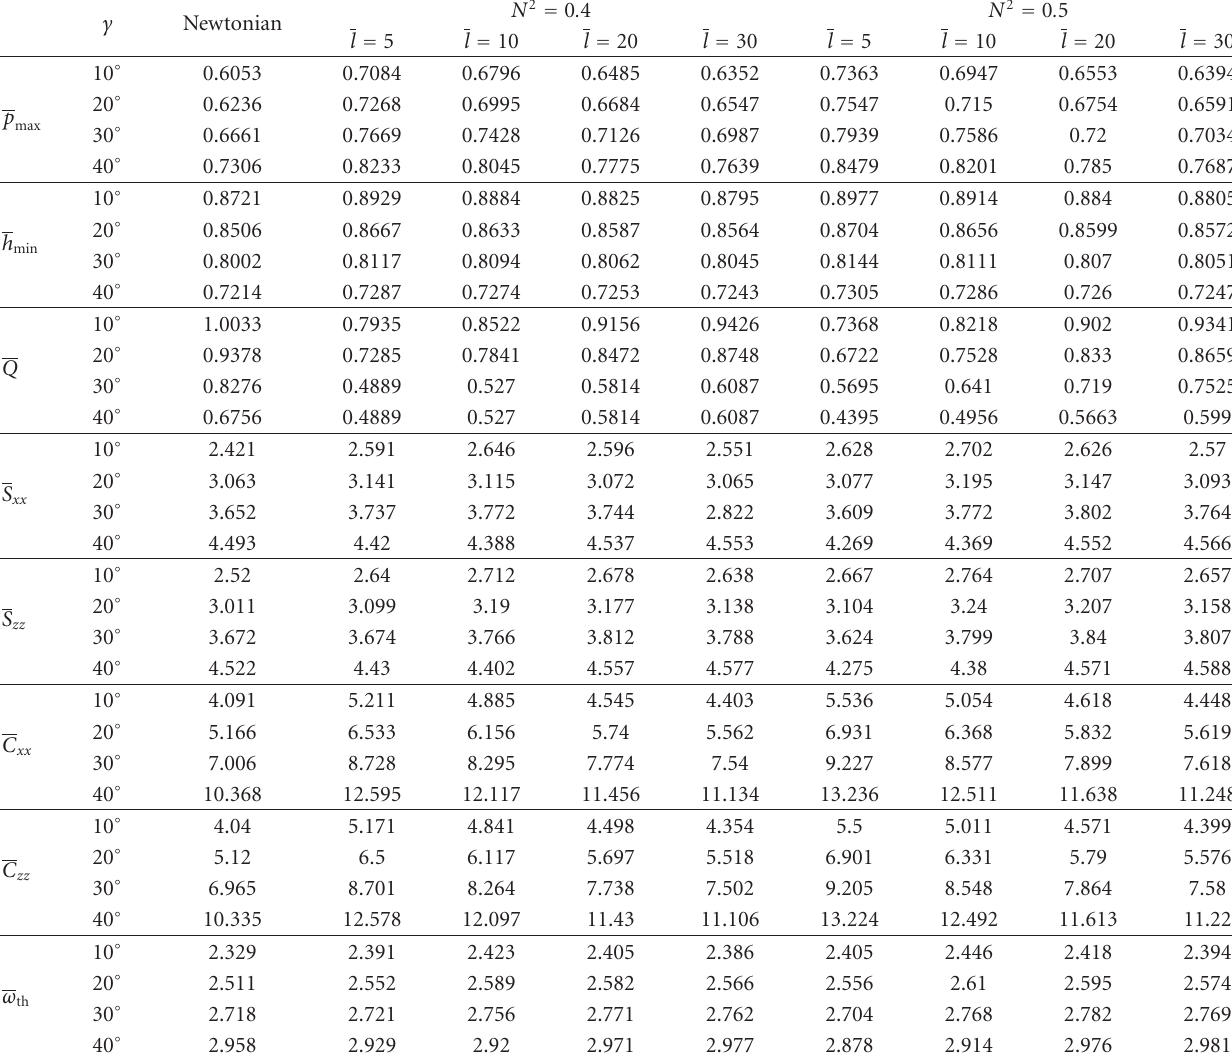
Table 2: Bearing performance characteristics of four-pocket conical hybrid journal bearing system operating with Newtonian and micropolar lubricant with di ff erent semicone